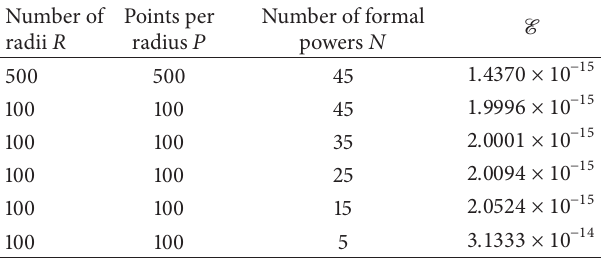
Figure 1: Example of a separable-variables exponential conductivity function 𝜎 = 𝑒 𝑥+𝑦 . Table 1: Relation between the error E and the number of formal powers, for the case when 𝜎 possesses an exponential form.